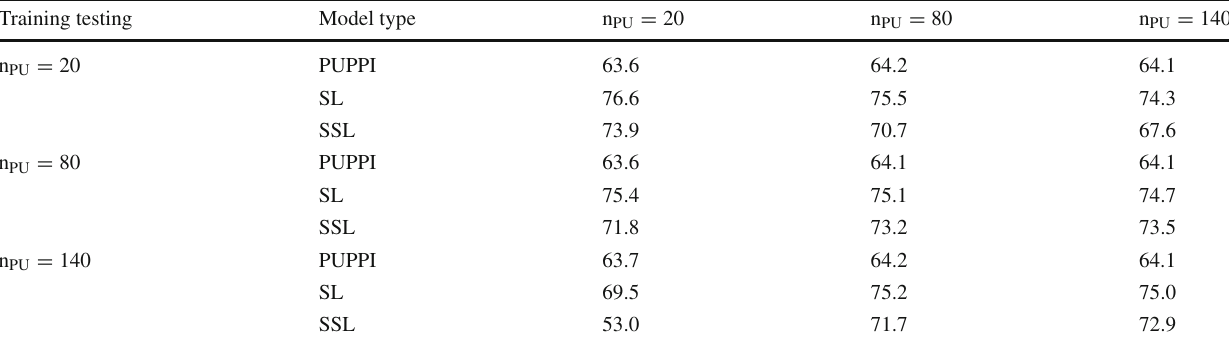
Table 3 AUC scores (%) of the PUPPI algorithm, supervised (SL) and semi-supervised (SSL) models trained and tested on three different pileup conditions: n PU = 20, 80, and 140